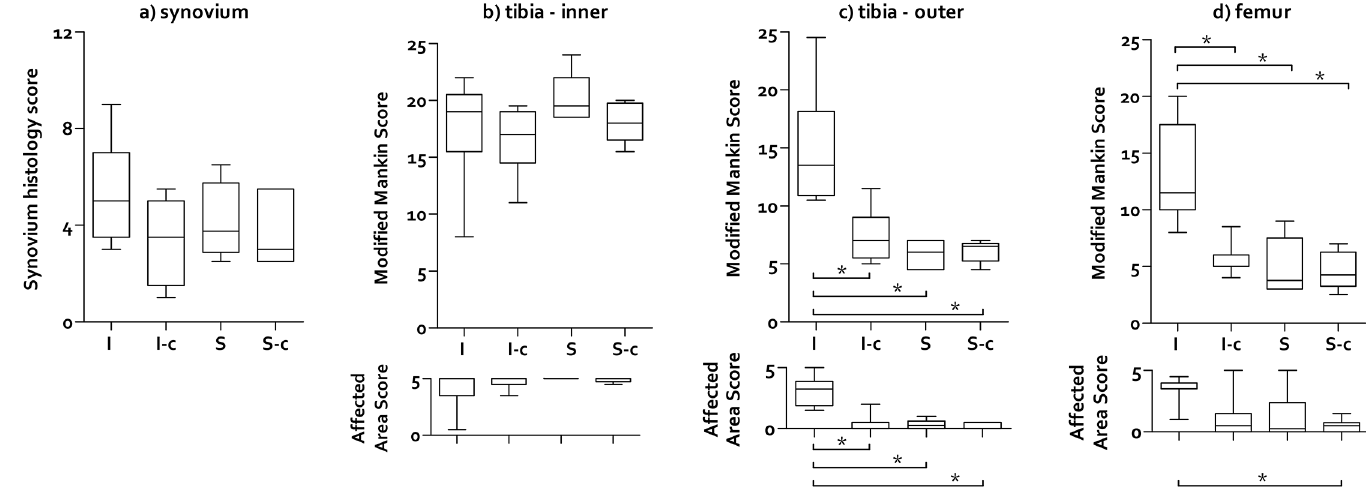
Fig 6. Synovium and cartilage histopathological scores represented as box plots. a) Synovium score. b) Inner tibia cartilage score. c) Outer tibia cartilage score. d) Femur cartilage score. The cartilage histopathological scores are split into the modified Mankin and Affected Area scores, representing respectively the structural/morphological condition of the cartilage and the extent of potential damage. I = Implant; I-c = Implant-control; S = Sham; S- c = Sham- control. The box extends from the 25 th and 75 th percentile and shows the median as a horizontal line crossing the box. The whiskers represent the minimum and maximum scores. * refers to a significant difference between two experimental